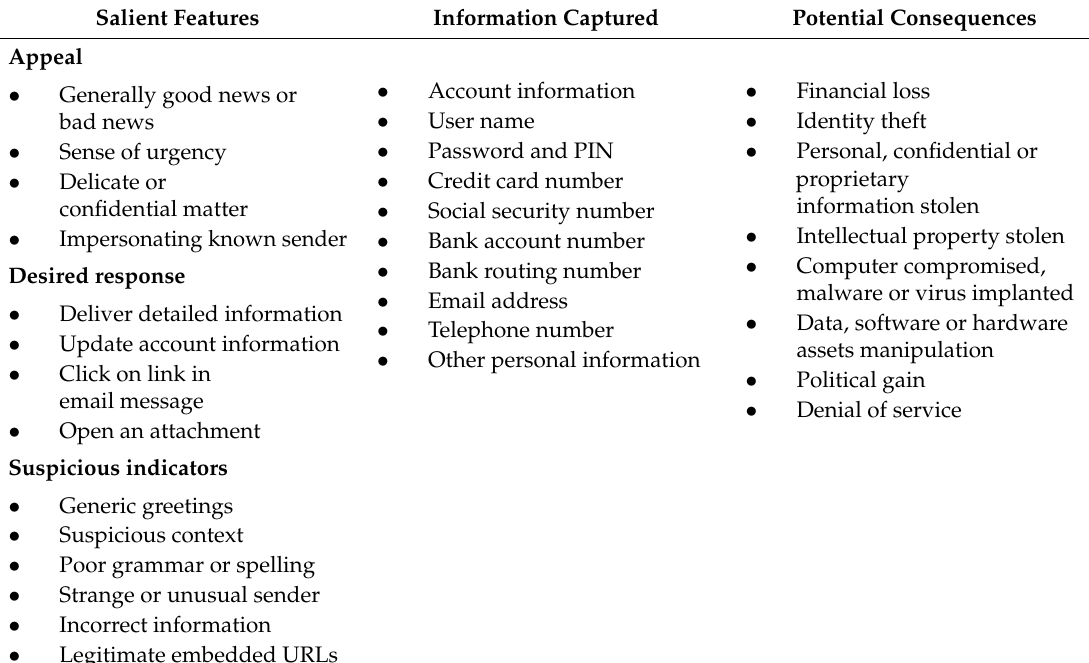
Table 1. Summary of social engineering attack